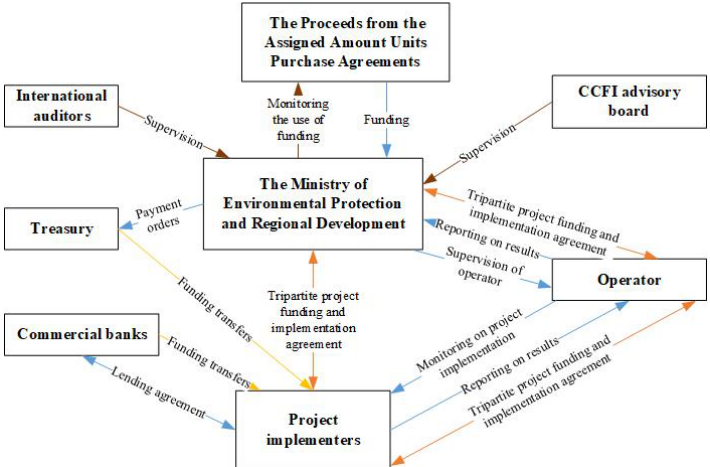
Fig. 1. Implementation scheme of CCFI program